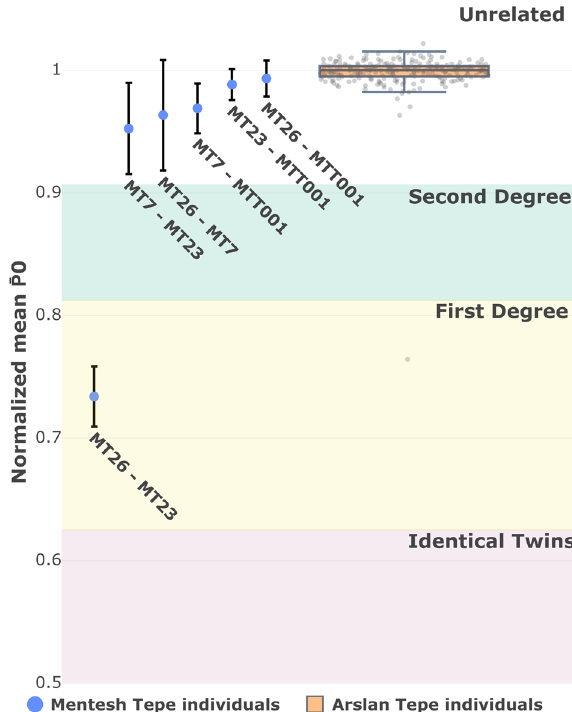
Fig. 3 Estimation of genetic relatedness of newly and previously sequenced Mentesh Tepe individuals. Sorted normalised average P0 values for all pairwise comparisons between Mentesh Tepe individuals (blue markers) and Arslan Tepe Late Chalcolithic/Early Bronze-Age Arslantepe individuals (orange boxplot), using the READ estimation method. Marker error bars indicate 95% con fi dence intervals for the observed average P0 estimation. Coloured areas represent the thresholds at which relatedness orders are considered by READ. Boxplot highlights the distribution of the observed normalised P0 of the Arslan Tepe individuals used for the normalisation step of READ, with each point corresponding to a given pair of proxy individuals (jittered along the horizontal axis). Lower and upper fences respectively represent the minimum and maximum sample point, excluding observations located below or above 1.5 the interquartile range. Boxspan: 25 th – 75 th